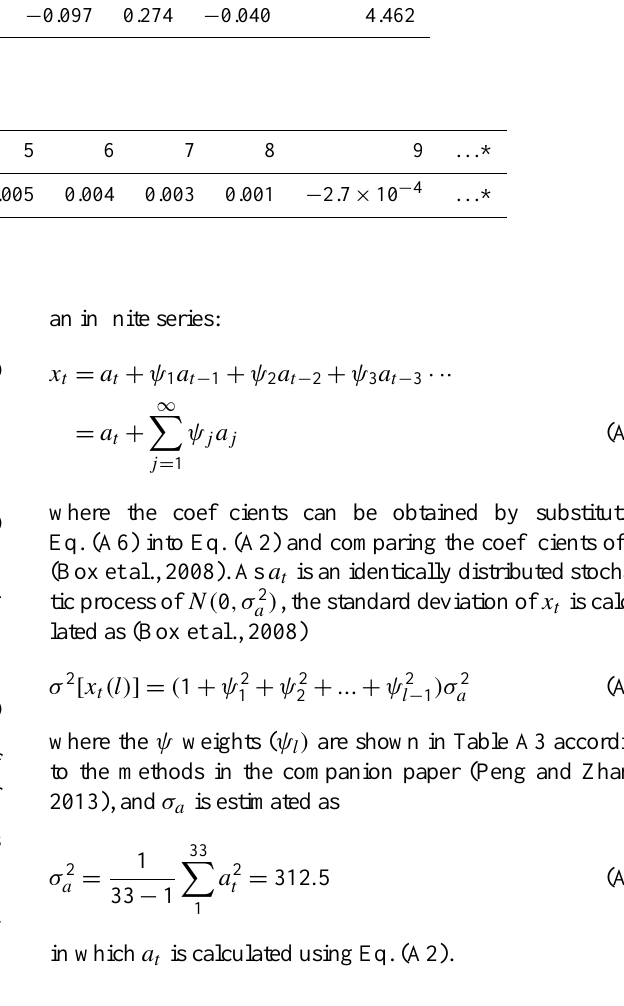
7 P ρ 2 (a) k k = 1